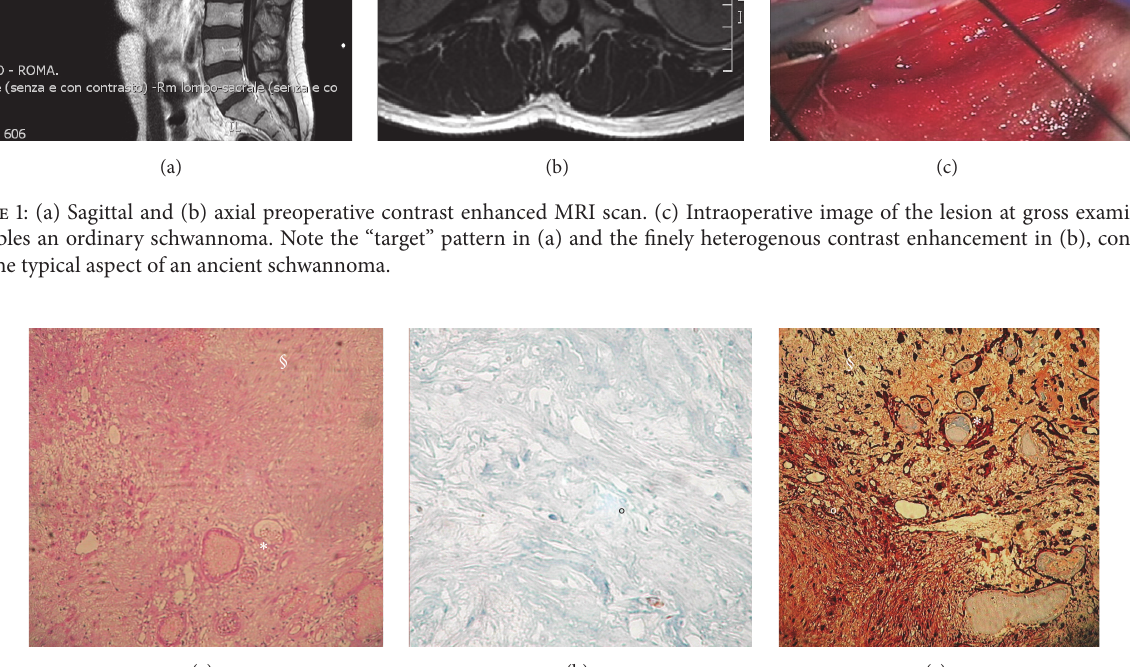
material in H&E stain, surrounded by a loose hypocellular fibrillary stroma with rare necrotic